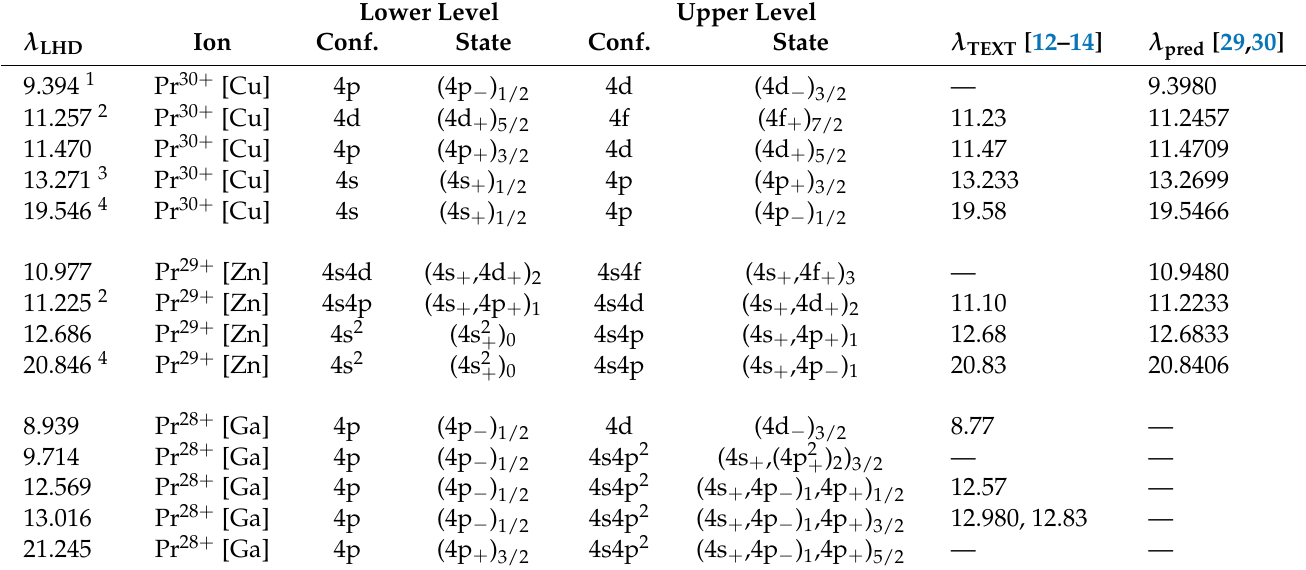
1 Blended with Fe XVIII. 2 Determined from the 2nd order spectrum. 3 Partially blended with Fe XXIII. 4 Observed by EUV_long